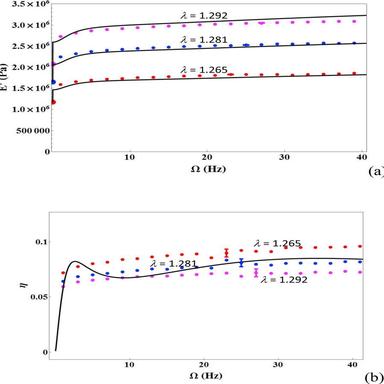
Storage modulus E and loss tangent η at three different initial stretches λ for the axial strip from the intact aorta from donor IX versus loading frequency Ω (Hz). The error bar quantifies the estimated measurement error. , experimental data for λ = 1.265; , experimental data for λ = 1.281; , experimental data for λ = 1.292; —, generalized Maxwell material model with NS=3. (a) Stress-strain law with indication of the three initial stretches; (b) storage modulus; (c) loss tangent.